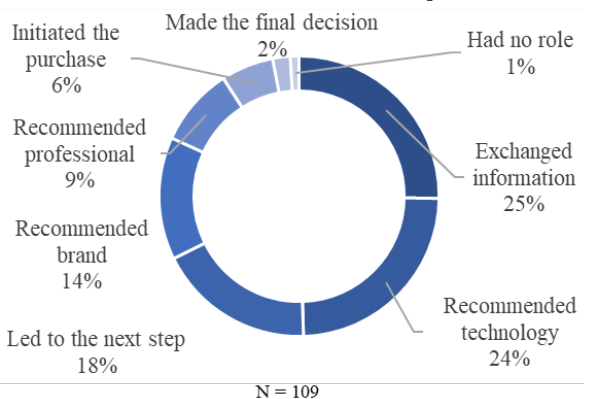
Figure 7. Role of the most relevant contact person.